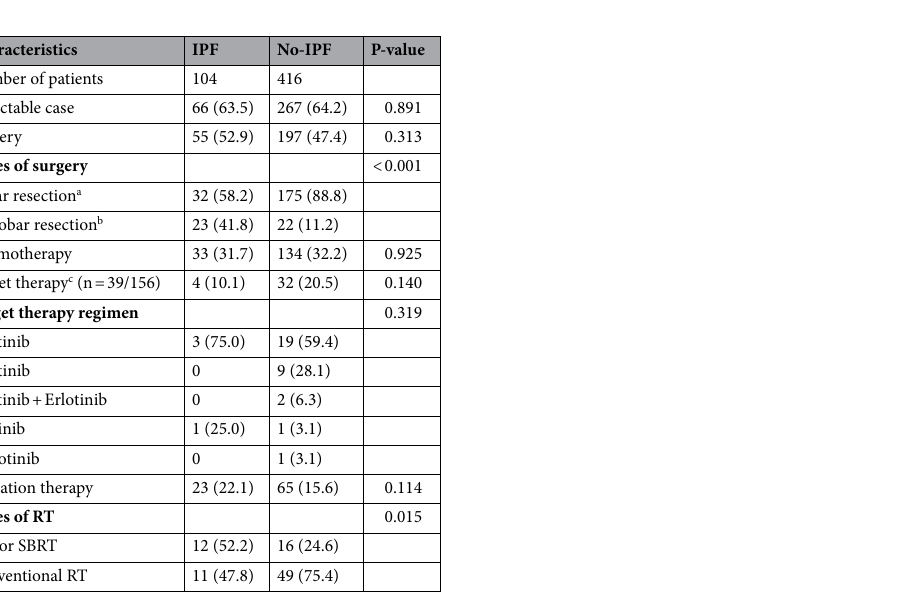
Table 3. Comparison of treatment of NSCLC between the IPF and no-IPF groups. Data are presented as number (%), unless otherwise indicated. NSCLC non-small cell lung cancer, IPF idiopathic pulmonary fibrosis, RT radiation therapy, SRS stereotactic radiosurgery, SBRT stereotactic body radiotherapy. a Lobar resection: lobectomy or more extensive resection (bilobectomy or pneumonectomy). b Sublobar resection: segmentectomy or wedge resection. c Information from only adenocarcinoma